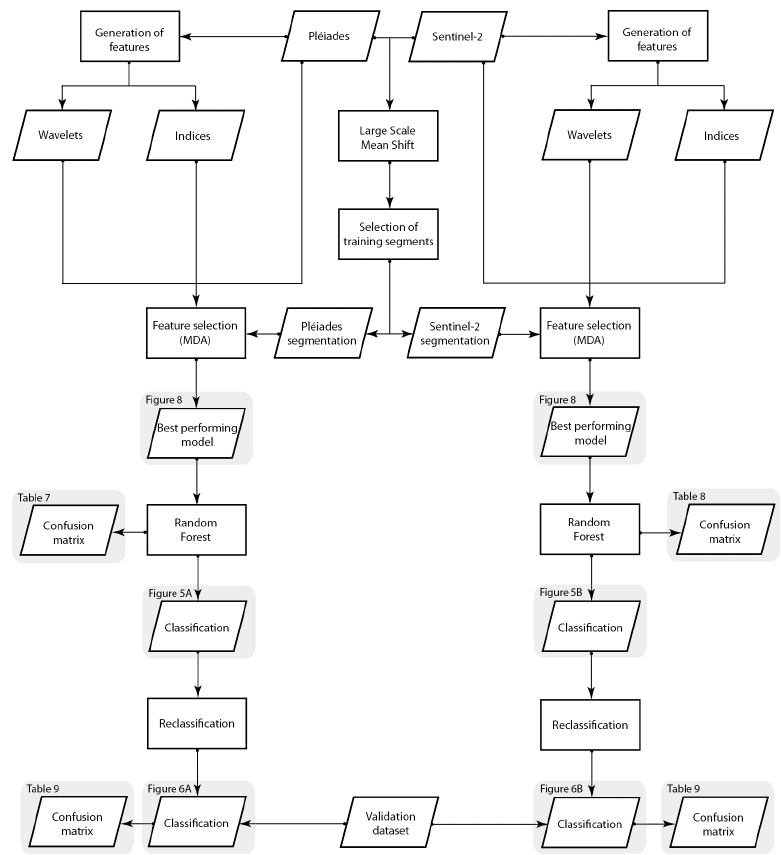
Figure 5. Workflow describing the classification process for both Pléiades and Sentinel-2 dataset.